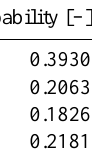
Table 3. Parameters of the bivariate Frank copulas in the construc- tion of the 3- and 4-dimensional vine copulas.